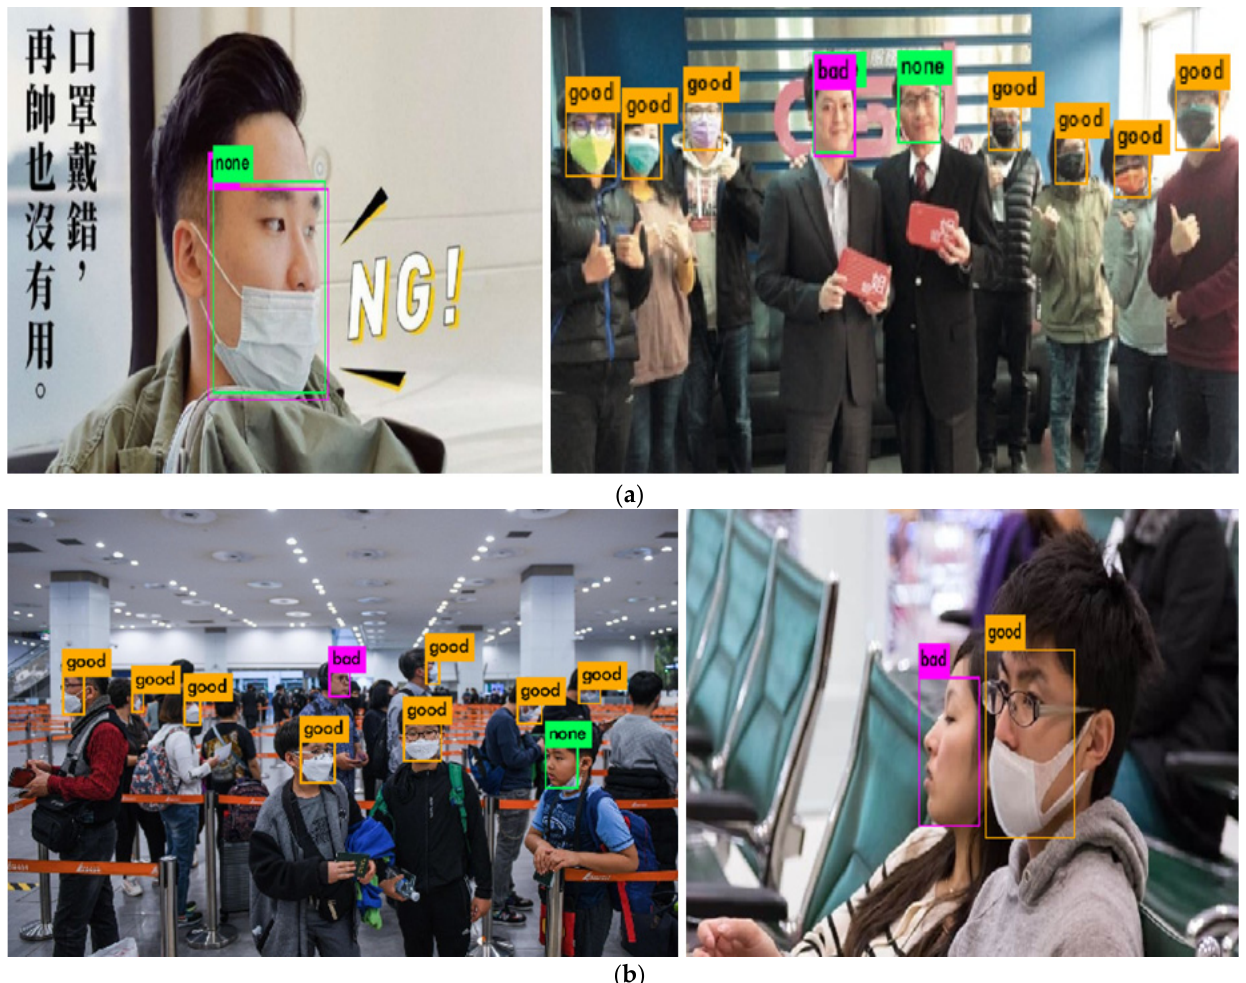
Figure 8. Failure Detection sample. ( a ) Face Mask Dataset (FMD) and ( b ) Medical Mask Dataset (MMD). Source of the human faces: The FMD and MMD datasets.